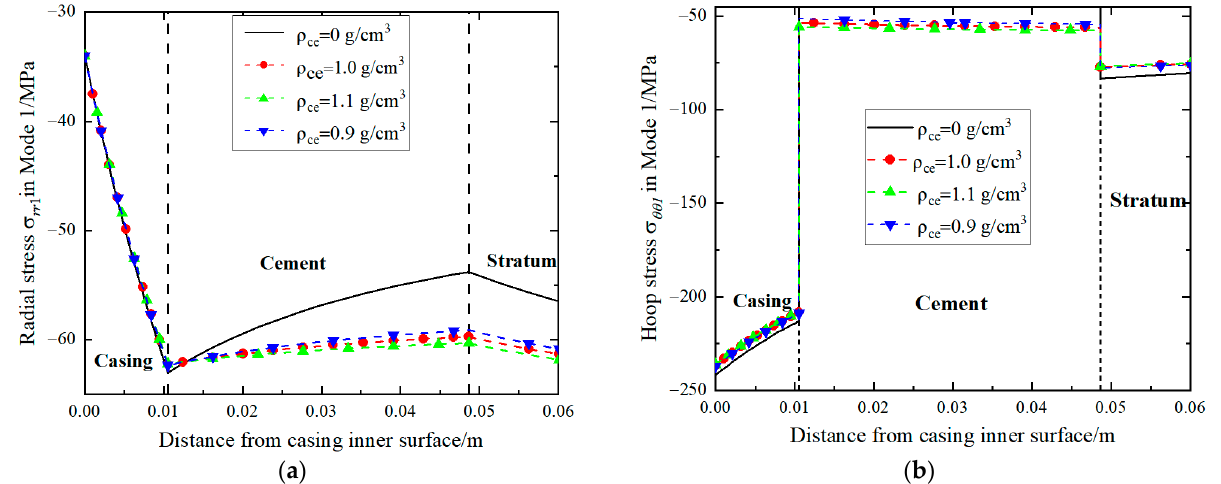
Figure 8. Influence of the initial stress state of cement on stress field within the casing-cement-stratum system: ( a ) Radial stress; ( b ) Hoop stress in Mode 1 of Sub-problem I. In this case, a vertical well is considered.